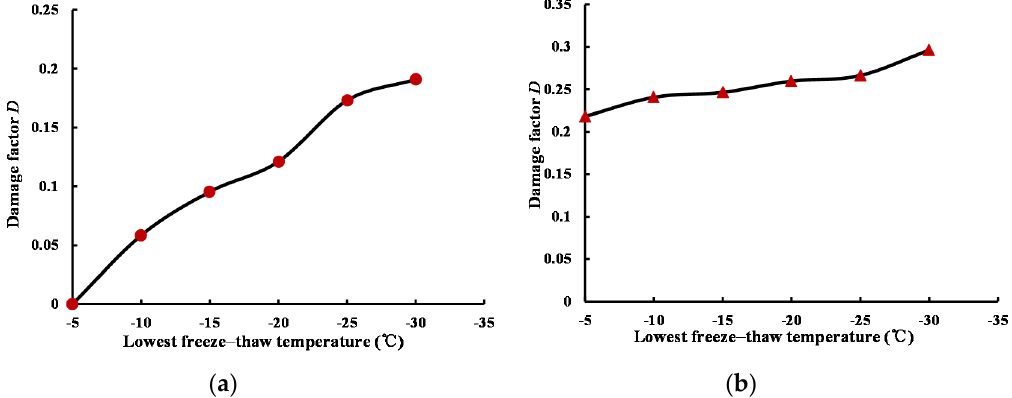
Figure 6. Freeze–thaw cycles and lowest freeze–thaw temperature versus damage D NT : ( a ) with different freeze–thaw cycles ( T = − 20 °C); ( b ) with different lowest freeze–thaw temperatures ( N = 20).